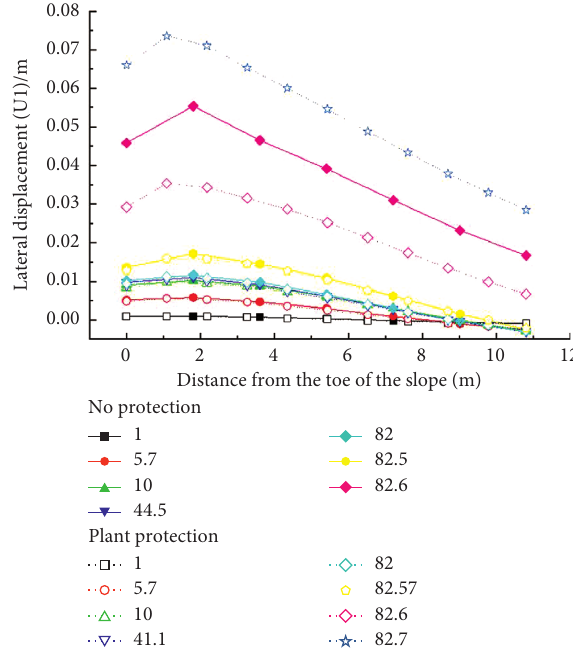
Figure 10: Vertical displacement of each characteristic point of the downhill foot at each time.